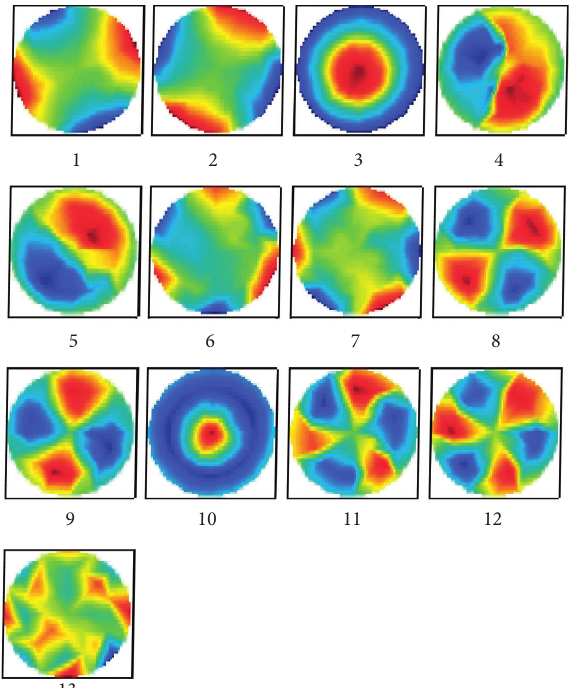
Figure 16: Contour plots of the mode shapes from the test.